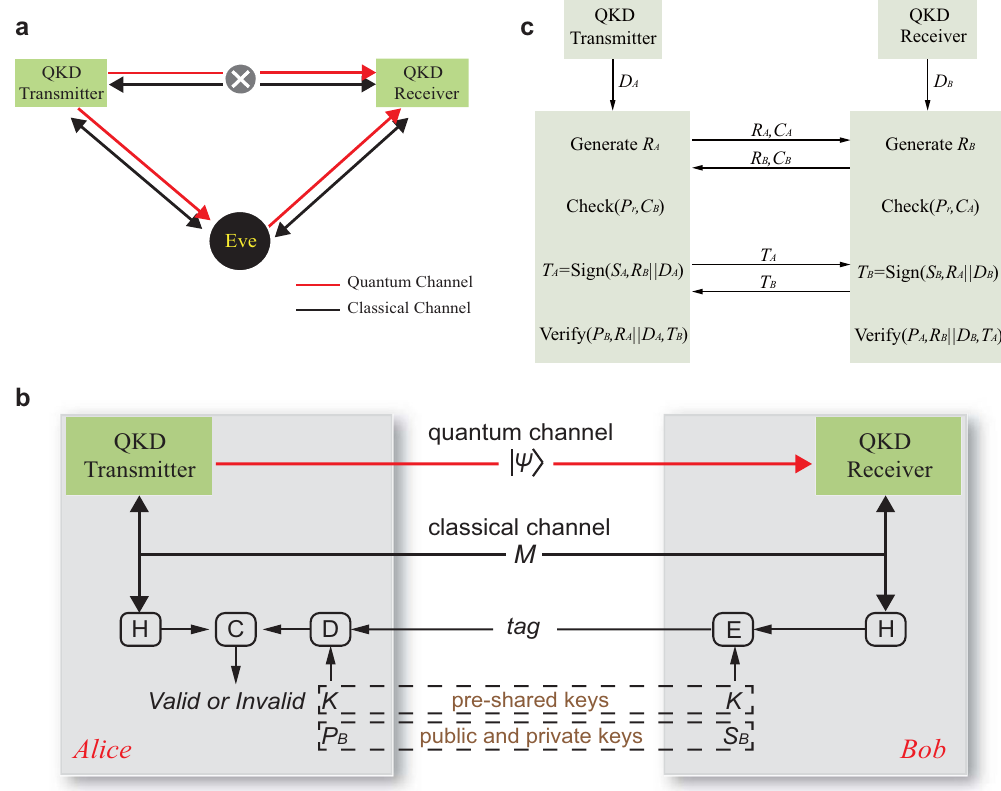
Fig. 1 Schematic of man-in-the-middle attack and fl ow diagram of post-quantum cryptography authentication. a As a middleman, Eve pretends to be a legitimate party. He cuts off the quantum channel, reconnects the legitimate parties, and carries out the man-in-the-middle attack. b The QKD transmitter sends quantum signals ( ψ j i ) through a quantum channel to the QKD receiver, and they carry out data processing via a classical channel by exchanging classical messages (M). To authenticate the classical messages, Alice and Bob each generate a digest using a hash function (H), which is the SM3 hash algorithm in our experiment. Then, Bob encrypts (E) his digest with a pre-shared key (K) or Bob ’ s private key ( S B ) and subsequently sends the tag to Alice. After receiving the tag, Alice decrypts (D) it with the same pre-shared key (K) or Bob ’ s public key ( P B ) and compares (C) the result with her own digest. If the two are the same, the authentication is successful; otherwise, the authentication fails. The fi gure shows that Alice authenticates Bob ’ s identity. In the experiment, we implemented two-way authentication, that is, Bob also authenticates Alice ’ s identity. c Alice and Bob exchange their own certi fi cates ( C A , C B ) and random nonce ( R A , R B ) with each other. Then, they use the public key of certi fi cate authority ( P r ) to verify that the other public key belongs to its identity, and use the PQC algorithm to sign the message digest ( D A , D B ) and the nonce under their own private keys ( S A , S B ) to generate signatures ( T A , T B ). Afterwards, they use the con fi rmed public keys of the other to verify the correctness of the received signatures. Because only the legitimate party has the corresponding private key, it can be con fi rmed that the message is signed legally. ∣∣ denotes concatenating two bit